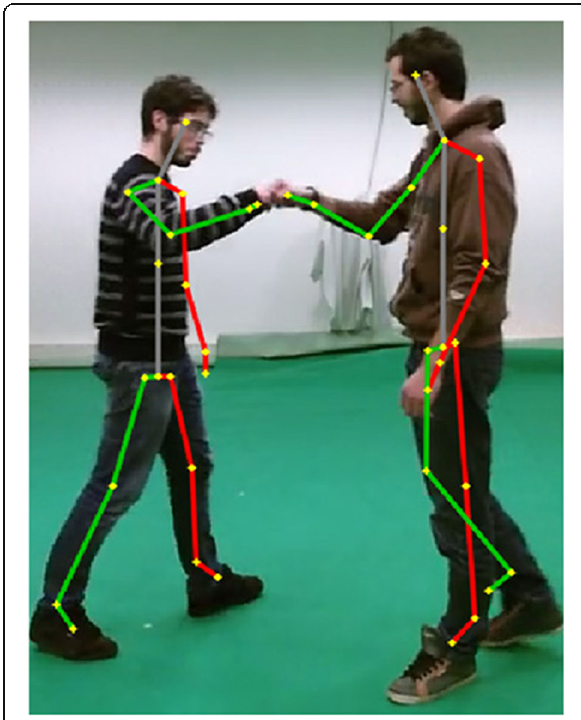
Fig. 2 Interaction with superimposed pose data. Green: right side, red: left